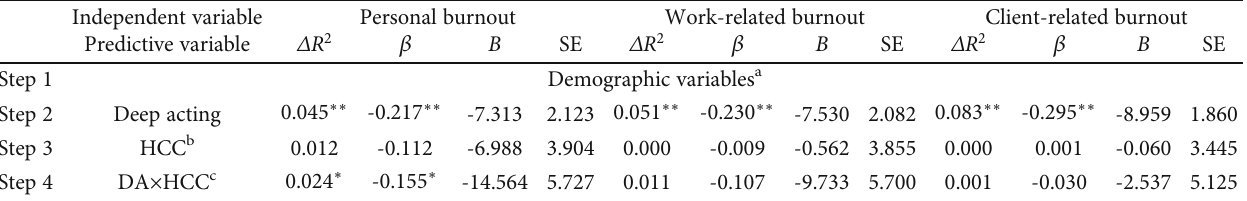
Table 5: Coe ffi cients of multiple linear regression of deep acting, hair cortisol content, and their interaction against Copenhagen job burnout ( n = 229 ).